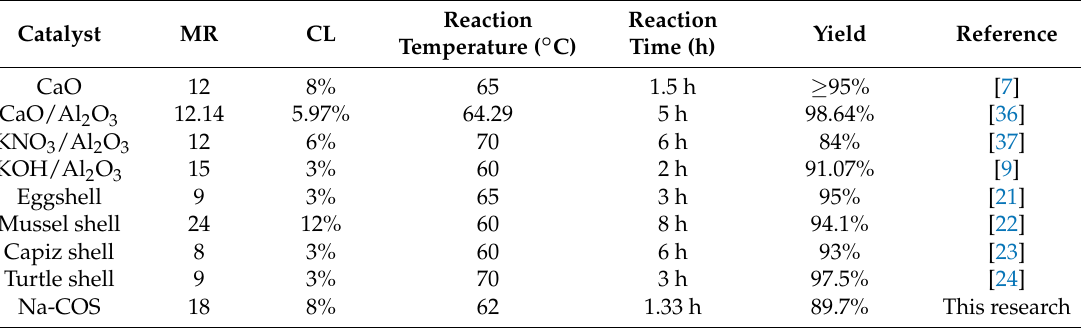
Table 1. Comparison of various solid base catalysts for transesterification